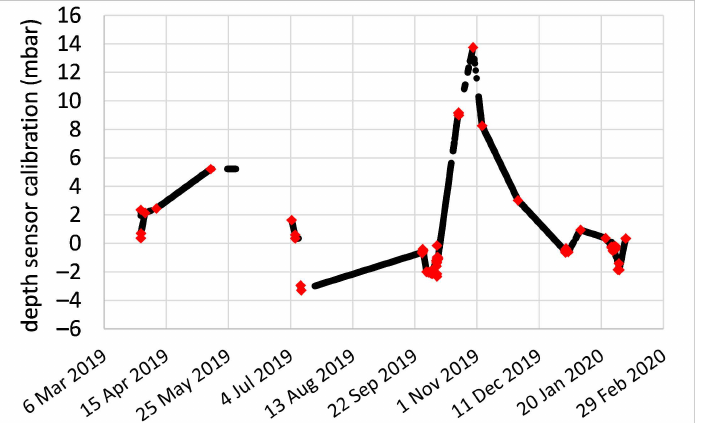
Figure A2. Depth sensor calibration coefficients throughout the monitoring period; red dot—Automatic sensor re-calibration when the HACH probe at its lowest detection limit 9 mm; black dashed line—The linear interpolated calibration coefficient between two automatically generated calibration point; the calibration coefficient is assumed to be constant for the period before the sensor dead.